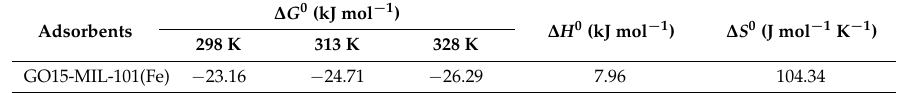
Table 4. The thermodynamic parameters for U(VI) adsorption on and the GO15-MIL-101(Fe) composite.